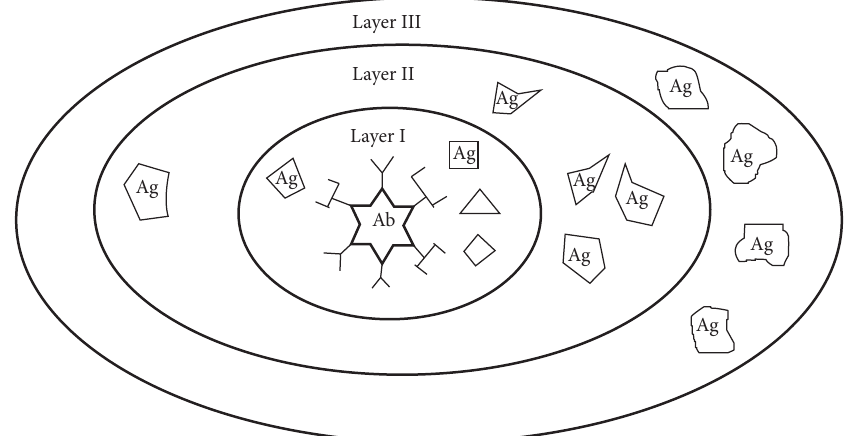
Figure 1: Antigen and antibody distribution structure.